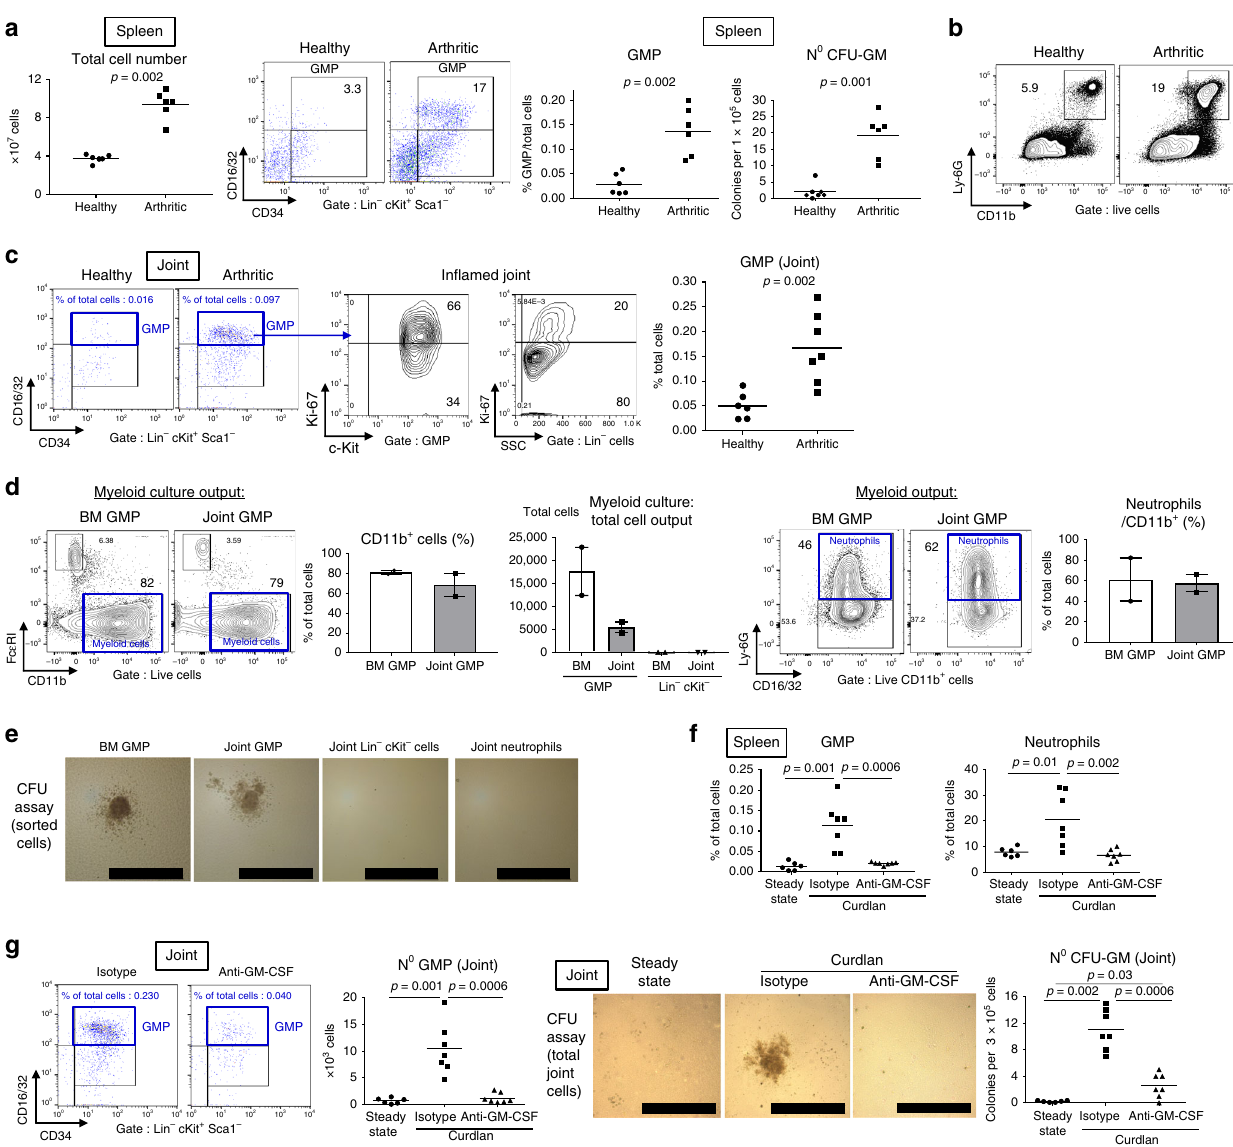
Fig. 4 Extramedullary hematopoiesis occurs inside in fl amed joints. a – c Spondyloarthritic mice were culled (week 5) and compared with healthy SKG mice. a Total splenocyte numbers, GMP staining, frequencies of GMPs and CFU-GM numbers in spleen. b Representative neutrophil staining in spleen. c GMP staining, Ki-67 staining of GMP cells and control Lin − cells, and frequencies of GMPs in paw joint single cell suspension. d Staining, frequencies of CD11b + myeloid cells cultured from GMPs isolated from in fl amed BM and joints and absolute numbers of myeloid cells following culture of indicated starting populations (left). Neutrophil staining following culture of GMPs from BM or joint and frequencies among myeloid cells (right). Bars represent mean and SEM of two independent experiments. e Representative photomicrographs of CFU-GMs formed from indicated cell populations. Scale bars = 500 µ m. f GMP and neutrophil frequencies in spleens of healthy, isotype, or anti-GM-CSF antibody treated mice. g GMP staining and absolute numbers in joints at week 6 – 7 (left). Representative photomicrographs and numbers of CFU-GMs obtained from joint cells of indicated groups (right), scale bars = 500 µ m. Data are representative of three ( a – c ) or two ( e – g ) independent experiments. Groups were compared using Mann – Whitney U tests. Source data are provided as Source Data fi